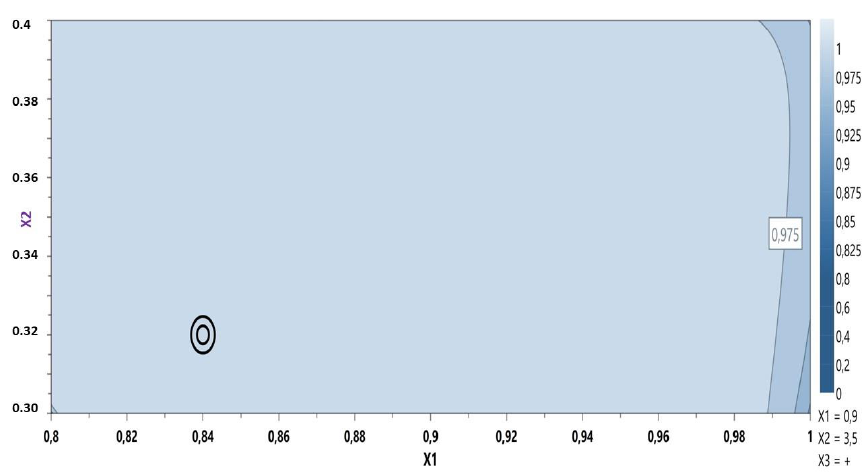
Figure 2. Desirability plot: MIC gel optimization.